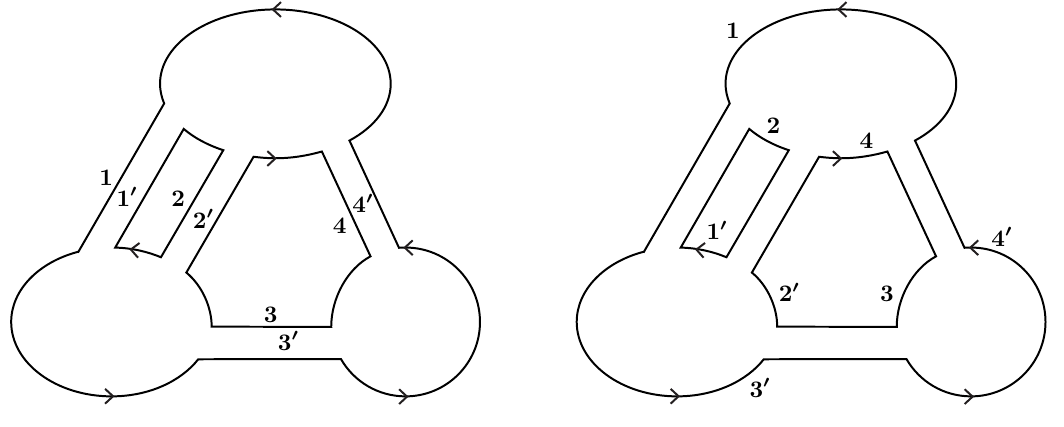
Figure 4 . (Left). Wick-contraction in the double-line notation with the numbers f 1 ; 1 0 ; 2 ; 2 0 ; : : : g labeling Wick-edges. (Right). The same graph whose rims are labeled. Both (cid:12)gures correspond to ! = (1 0 2)(2 0 43)(13 0 4 0